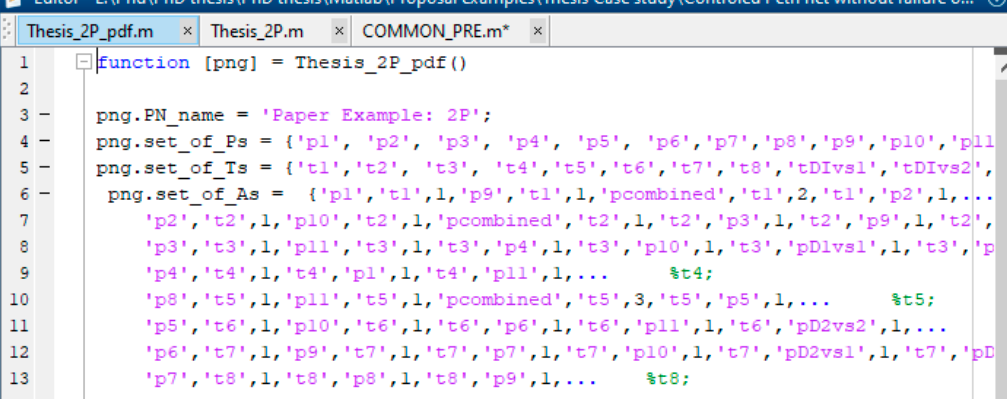
Figure 8. PDF file of the colored controlled S 3 PR Petri net model from Figure 7.